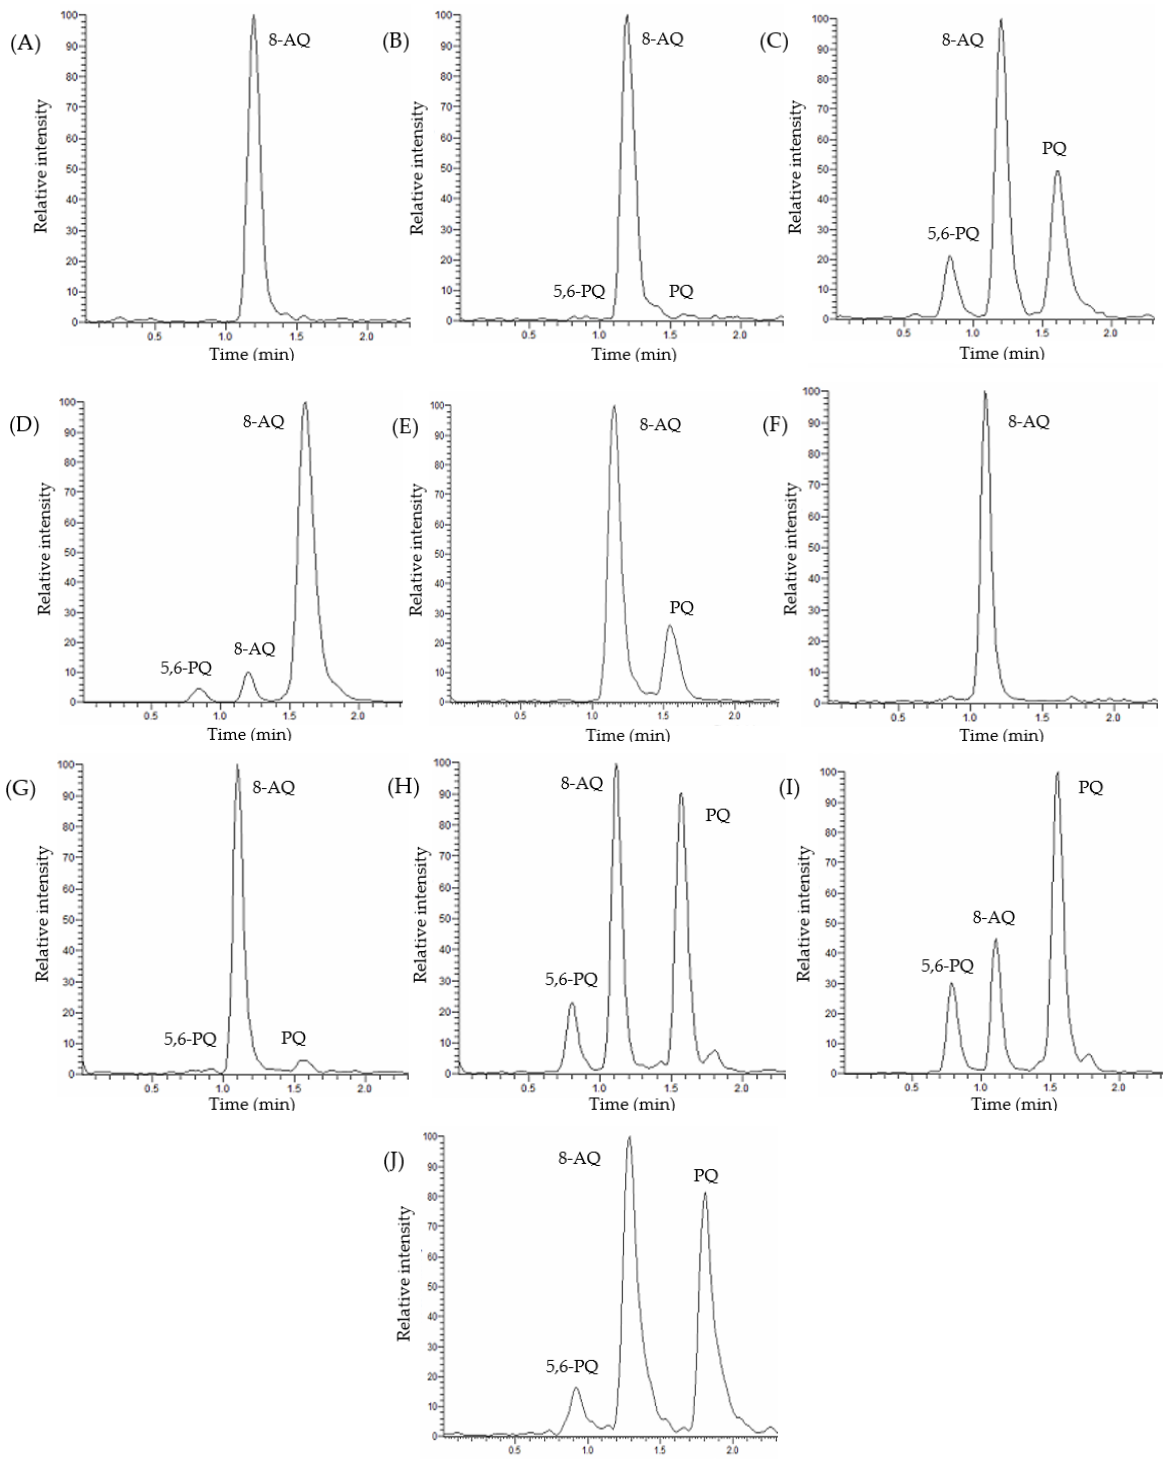
Figure 2. Chromatograms of 5,6-PQ, 8-aminoquinoline (8-AQ), and PQ in human plasma and urine. ( A ) Blank plasma with an internal standard (IS). ( B ) Spiked plasma at low limit of quantitation (LLOQ) for PQ and 5,6-PQ. ( C ) Spiked plasma at 600 ng/mL for PQ and 5,6-PQ. ( D ) Spiked plasma at 1500 ng/mL for PQ and 5,6-PQ. ( E ) A clinical trial plasma sample. ( F ) Blank urine with an IS. ( G ) Spiked urine at LLOQ for PQ and 5,6-PQ. ( H ) Spiked urine at 600 ng/mL for PQ and 5,6-PQ. ( I ) Spiked urine at 1500 ng/mL for PQ and 5,6-PQ. ( J ) A clinical trial urine